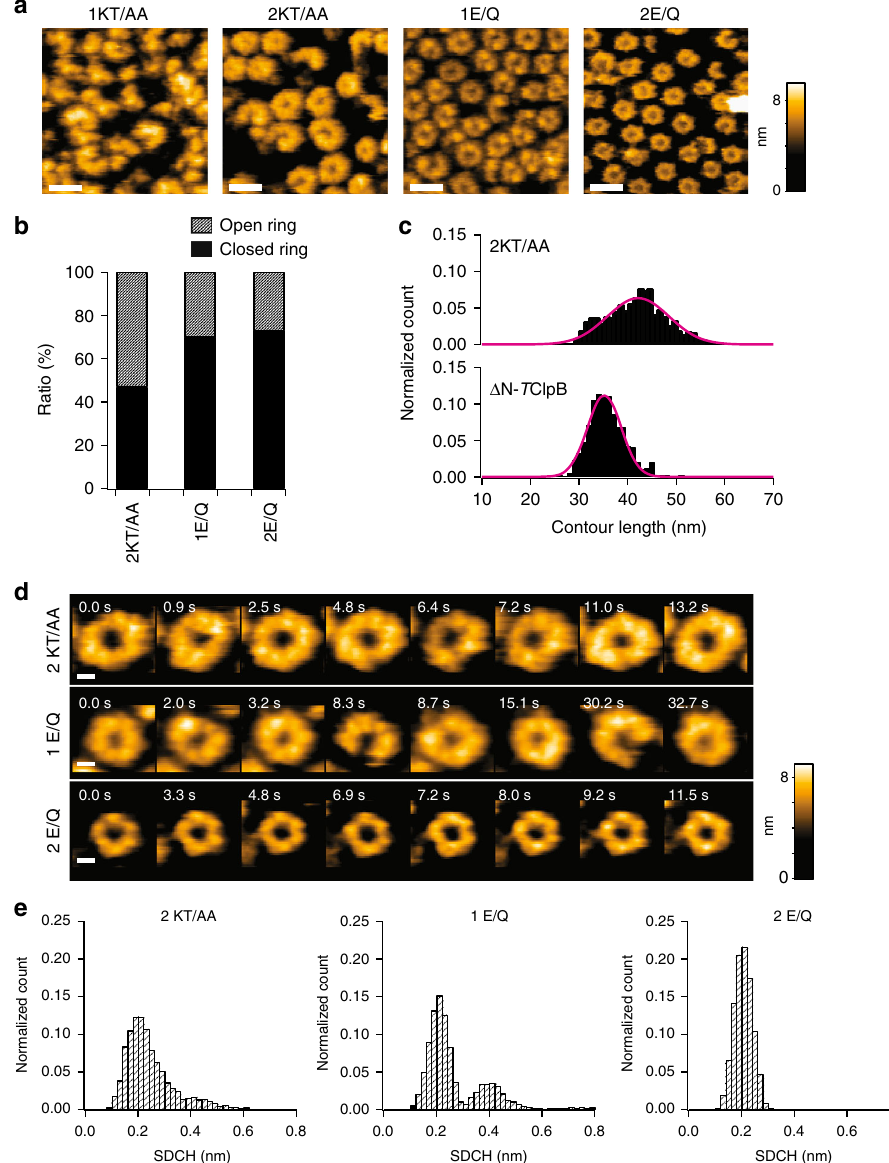
Fig. 3 Oligomeric forms of Walker motif mutants. a HS-AFM images of Walker A (1KA/AA and 2KT/AA) and Walker B (1E/Q and 2E/Q) mutants observed in the presence of 1 mM ATP. Scale bars, 20 nm. Z color bar, 0 to 9.6 nm. b Percentages of closed (black area) and open (hatched area) forms of 2KT/AA (1102 molecules), 1E/Q (388 molecules) and 2E/Q (516 molecules). c Histograms of contour length along the closed rings of Δ N- T ClpB (397 molecules) and 2KT/AA (520 molecules). The center values and widths fi tted by Gaussians are 35.2 nm and 5.3 nm ( Δ N- T ClpB), respectively, and 42.1 nm and 9.0 nm (2KT/AA), respectively. d Clipped HS-AFM images of 2KT/AA, 1E/Q, and 2E/Q mutants in the presence of 1 mM ATP. Scale bars, 5 nm. Z color bar, 0 to 9.1 nm. e Histograms of SDCH along the rings of 2KT/AA (3543 images from 32 molecules), 1E/Q (5279 images from 9 molecules) and 2E/Q (7287 images from 9 molecules). The frequencies of transition cycle between round and distorted closed states of 1E/Q and 2E/Q mutants are 0.28 ± 0.06 s − 1 and 0.022 ± 0.002 s − 1 (means ± s.d.),